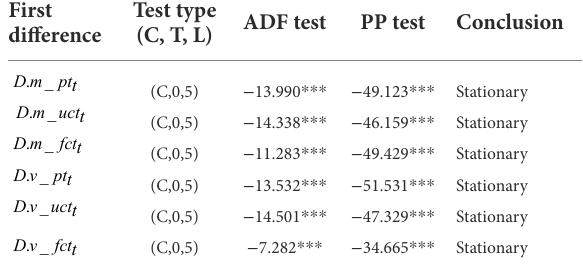
TABLE 2 Stationary